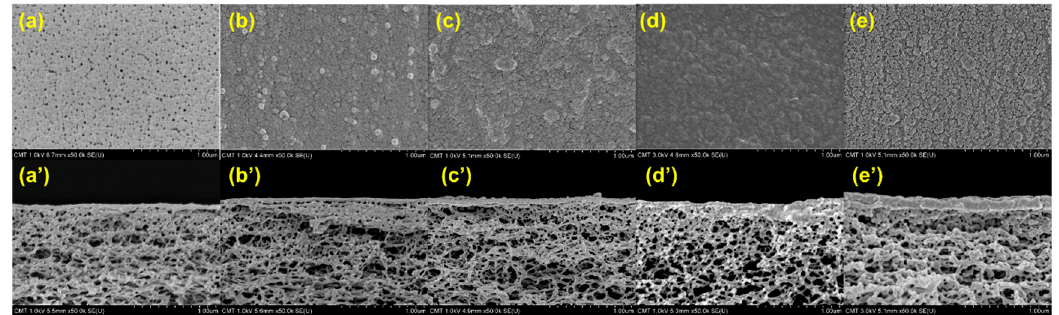
Figure 3. FESEM images of ( a , a’ ) CA, ( b , b’ ) TFC tetralin , ( c , c’ ) TFC toluene , ( d , d’ ) TFC hexane , and ( e , e’ ) TFC isopentane .